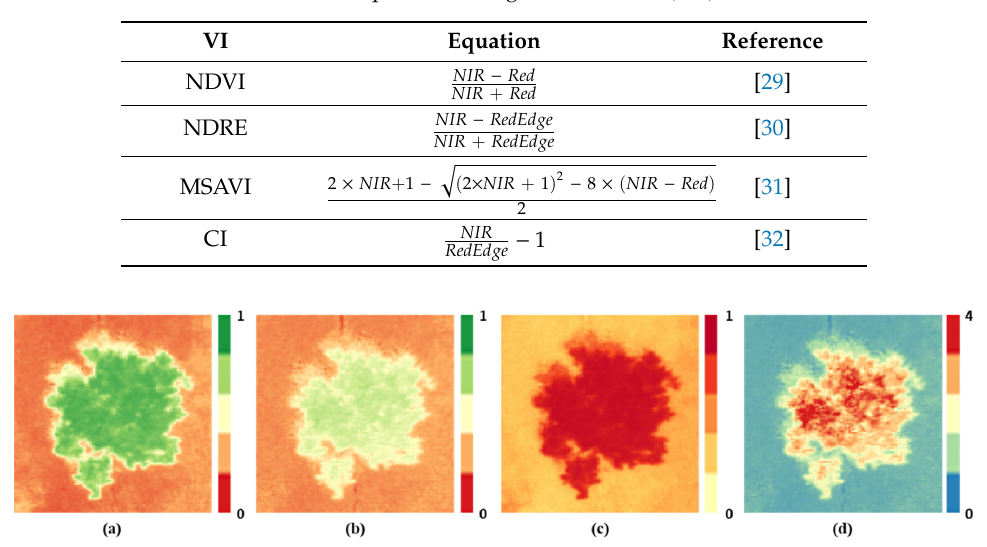
Figure 2. Example of individual tree detection: ( a ) a tree in a color-infrared (CIR) image, ( b ) canopy cover from the normalized difference vegetation index (NDVI) and the canopy height model (CHM), ( c ) individual tree segment after morphological filtering with the equivalent diameter (red circle), and ( d ) centroid of the individual tree (yellow dot) and individual tree boundary (yellow square).